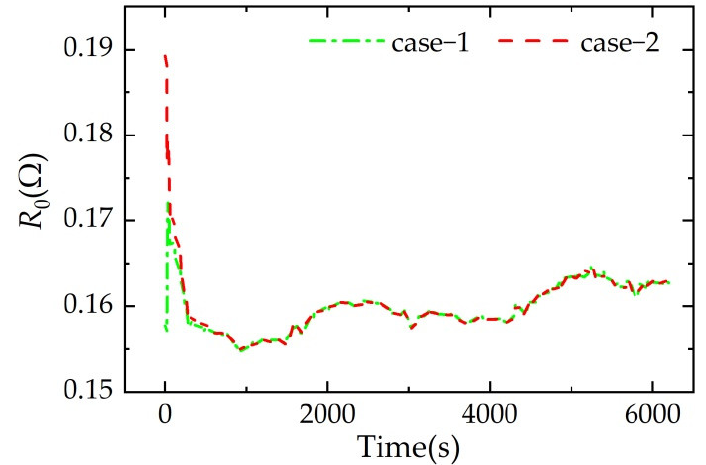
Figure 18. Identification curves of R 0 of two cases.